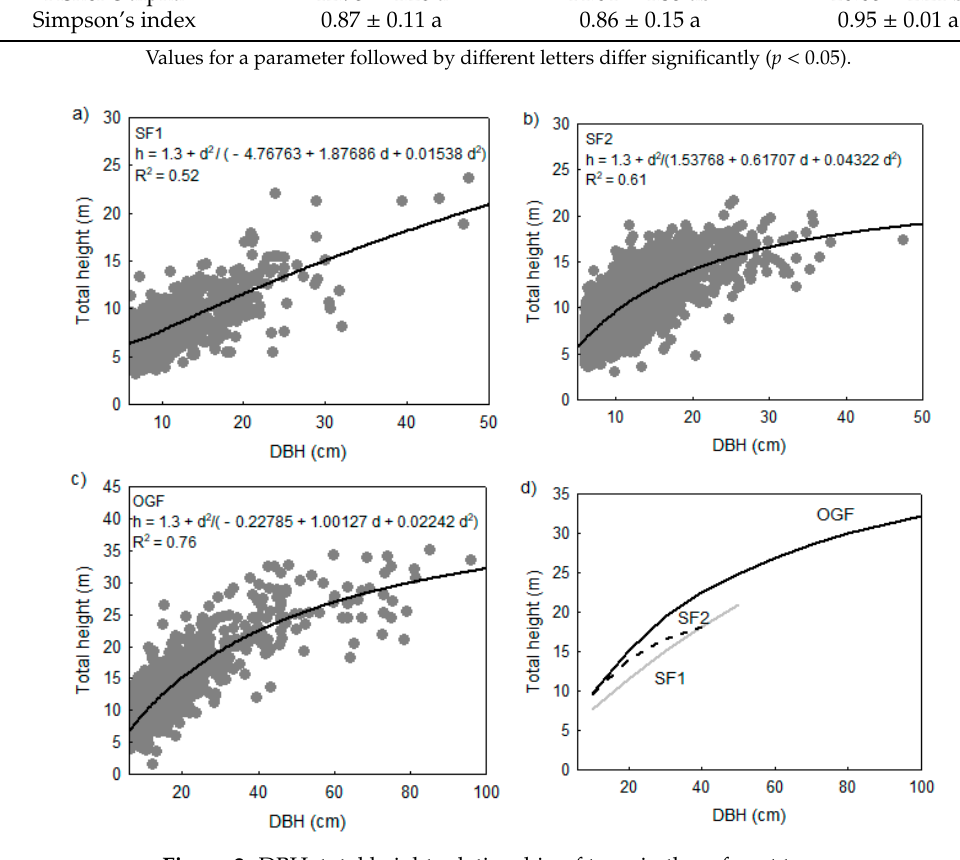
Table 1. Structural characteristics and species diversity of the three forest types, (Mean ± SD).